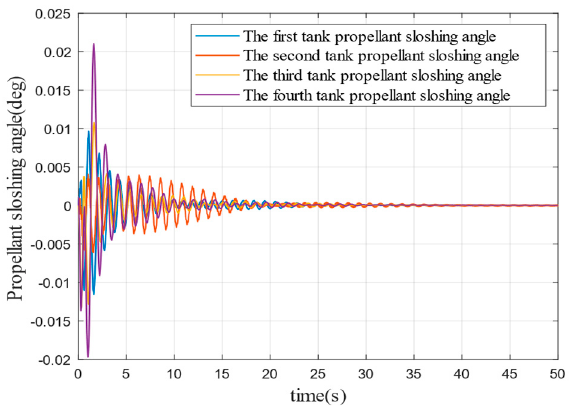
Figure 19. Fuel sloshing angle without considering external disturbances.